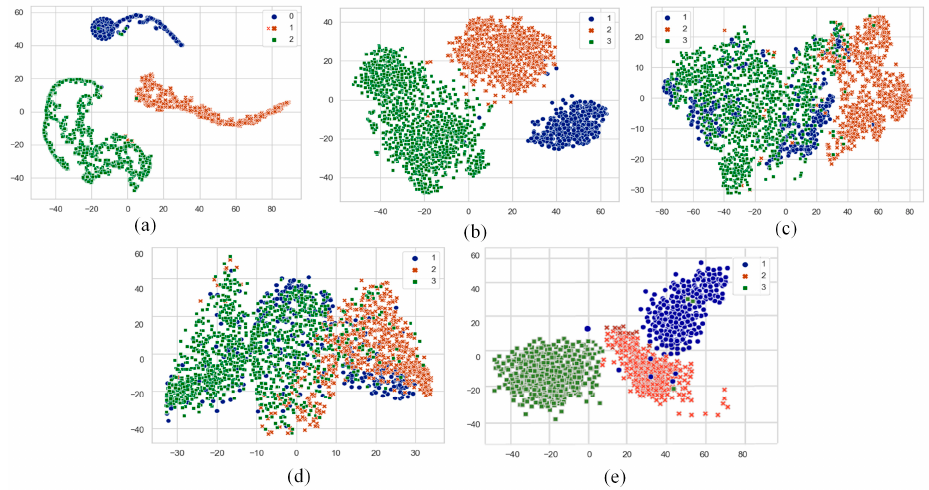
Figure 5. Visualization of five CNN networks: ( a ) VGG16; ( b )Inception V3; ( c ) ResNet18; ( d ) MobileNet; and ( e ) EfficientNet V1 .